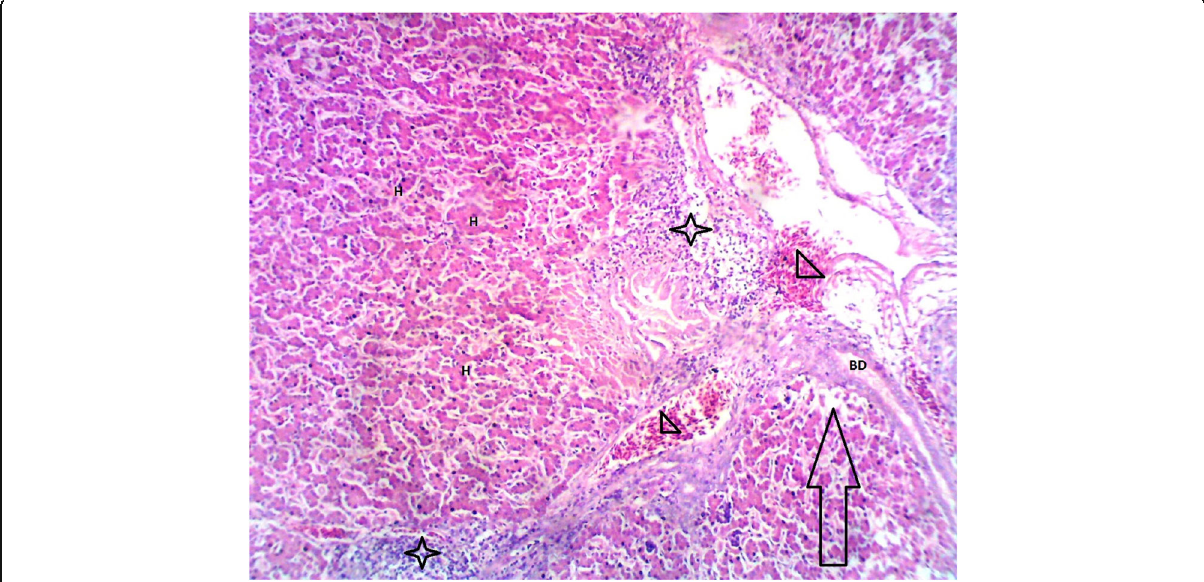
Fig. 2 Representative micrograph of liver section (× 400) of broiler chicks fed 0.2% PCM supplemented diet. This section shows the hepatic composed of the hepatic portal region (arrow) composed of the hepatic vessels, lymphatics, and bile duct (BD). The section shows marked proliferation of polymorphonuclear and mononuclear cells (arrow and